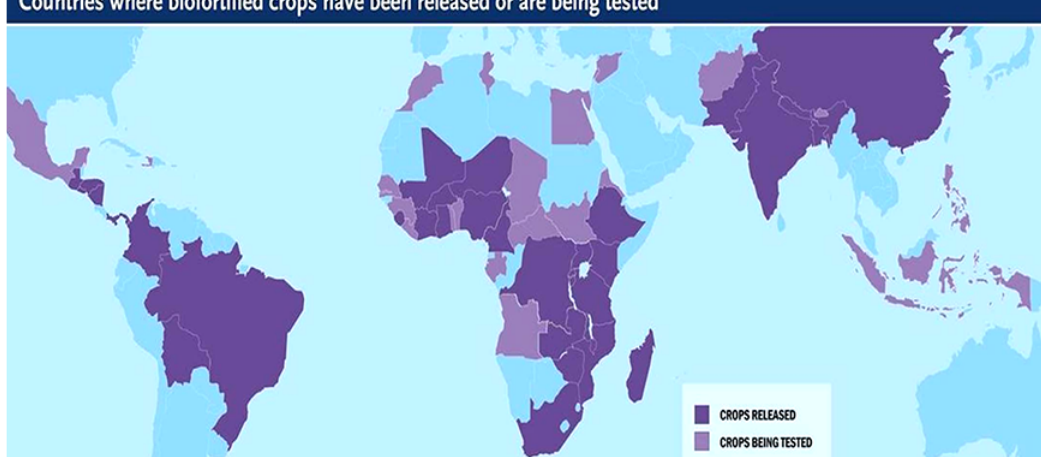
Fig. 1 Countries with biofortified crops, released and tested: dark purple color indicates the countries with biofortified crops and the light purple color indicates where biofortified crops are being tested (source: